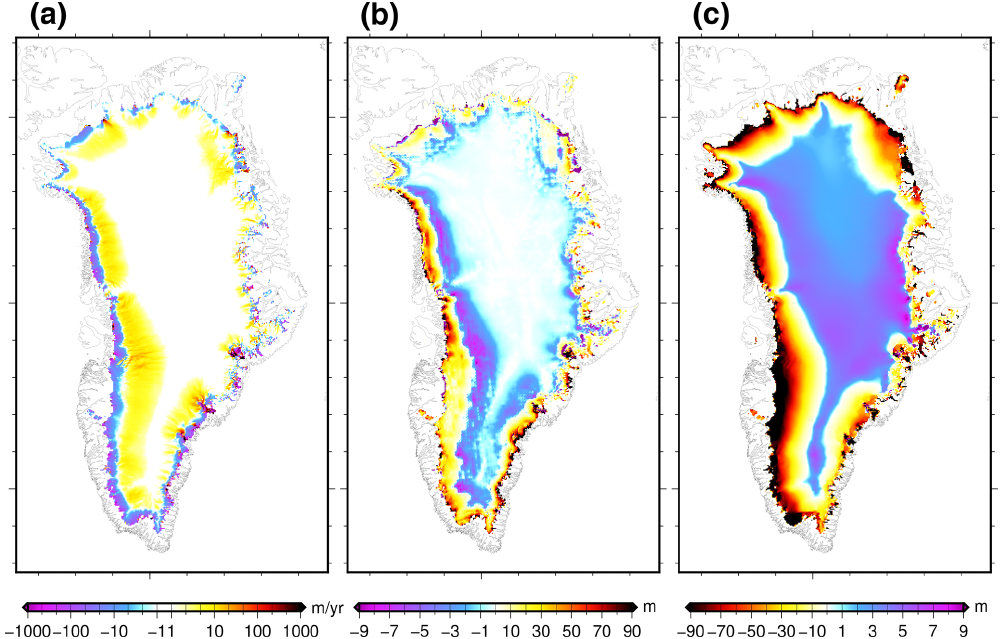
Figure 10. (a) Simulated surface velocity change during the projection run (2096–2100 with respect to 2015–2019) using MIROC5 forcing under RCP8.5 with a medium oceanic sensitivity. (b) Change in the dynamical contribution to ice thickness change in 2100 (see text for definition) for this same experiment. (c) Simulated ice thickness change (2100–2015). For all panels, we corrected the changes using the ones simulated in the control experiment ctrl_proj over the same period. The range − 1 to 1myr − 1 is set to white for velocity difference ( a ). The colour scale is not symmetrical for (b) and (c)